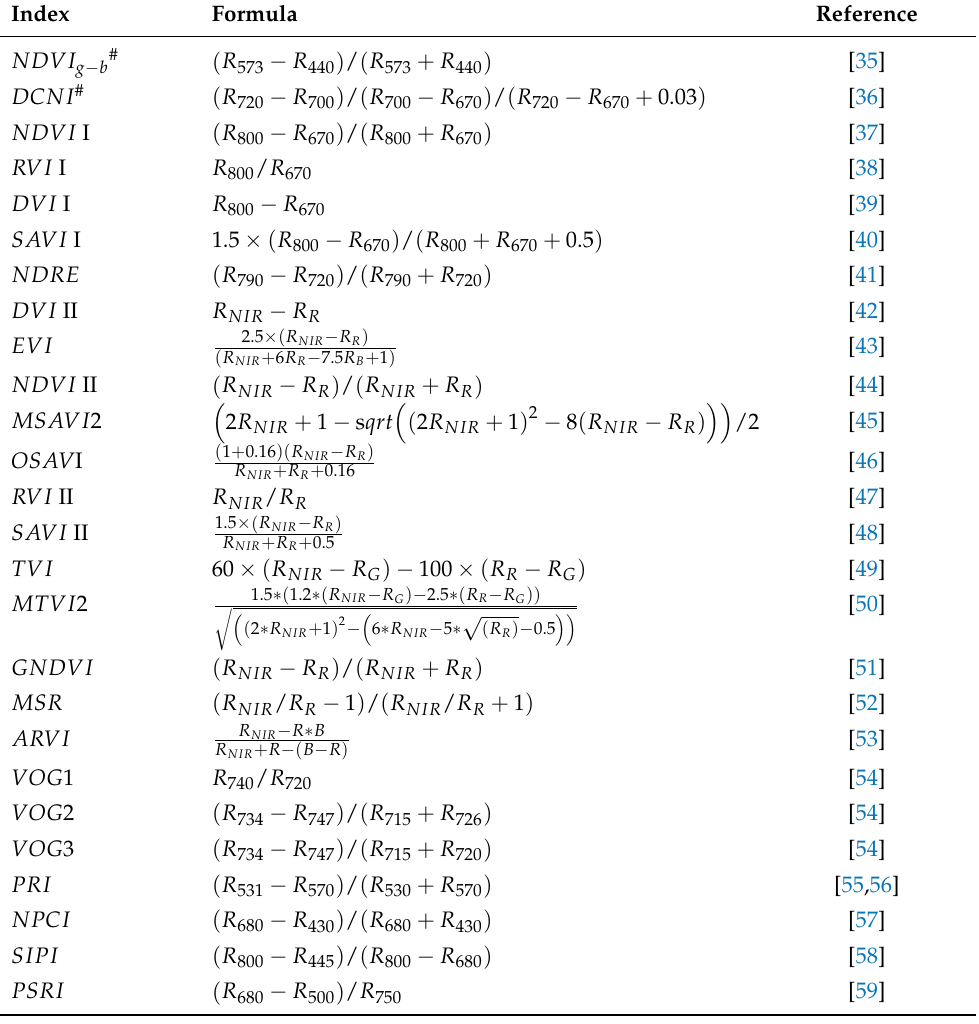
Table 1. The calculation formulas for vegetation